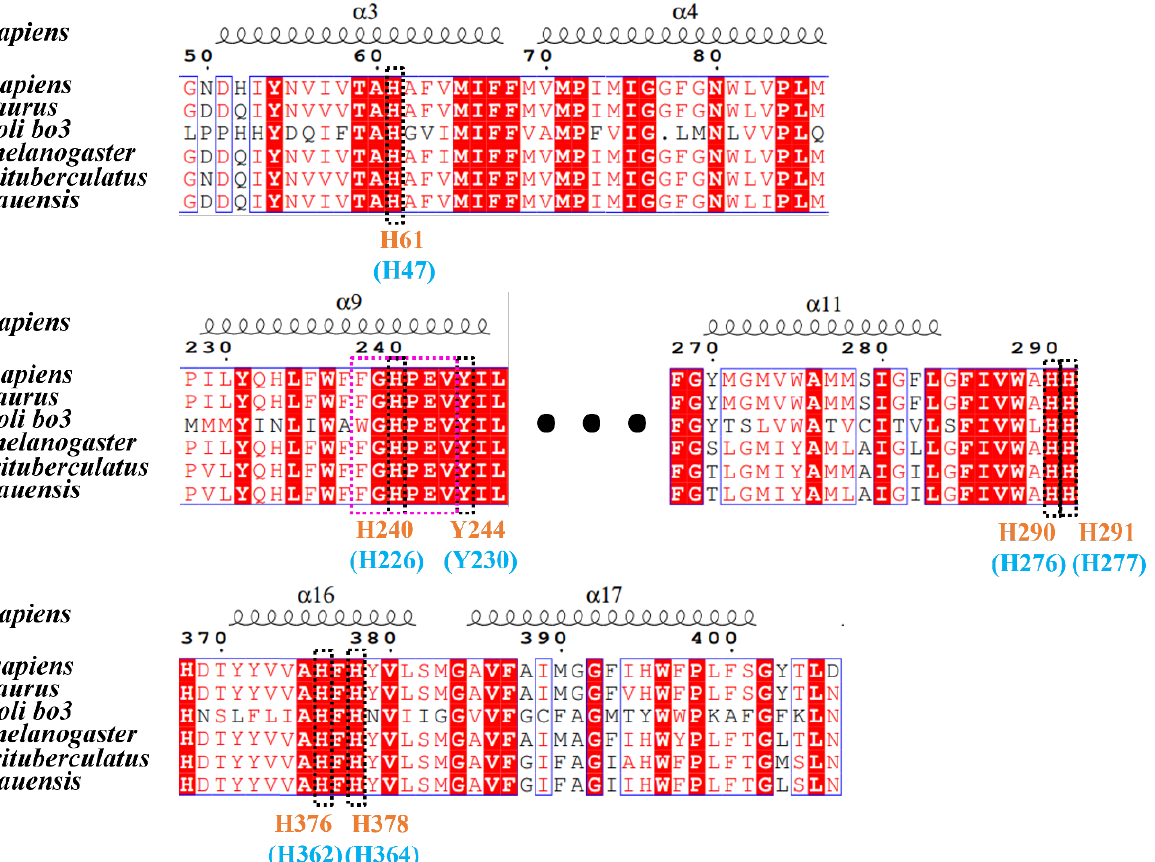
Figure 4. Sequence alignment of the COX1 type A1 motif in six species (accession numbers in parentheses). H. , Homo (AGW78696), B. , Bos (P00396), E. , Escherichia (P0ABI8), D. , Drosophila (AAF77227), P. , Portunus (QPD06751), M. , Munidopsis (QFG40073). Red boxes and white characters indicate strict sequence identities, and red characters show residues with high similarity. Black-dashed boxes and orange labels indicate the heme-interacting residues of human COX1 (H61, H240, Y244, H290, H291, H376, and H378). Cyan labels represent the H47, H226, Y230, H276, H277, H362, and H364 residues of M. lauensis COX1. Magenta-dashed boxes represent the COX1 type A1 motif (-XGHPEV-). Secondary structures are represented above the alignment.